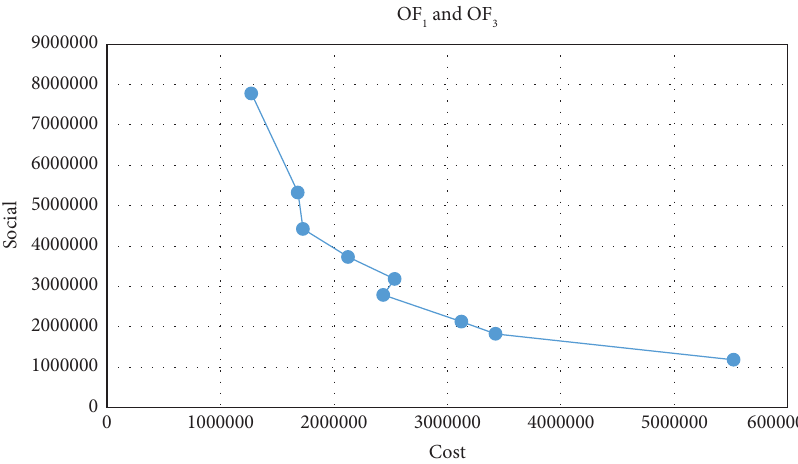
Figure 7: Pareto frontier of the numerical